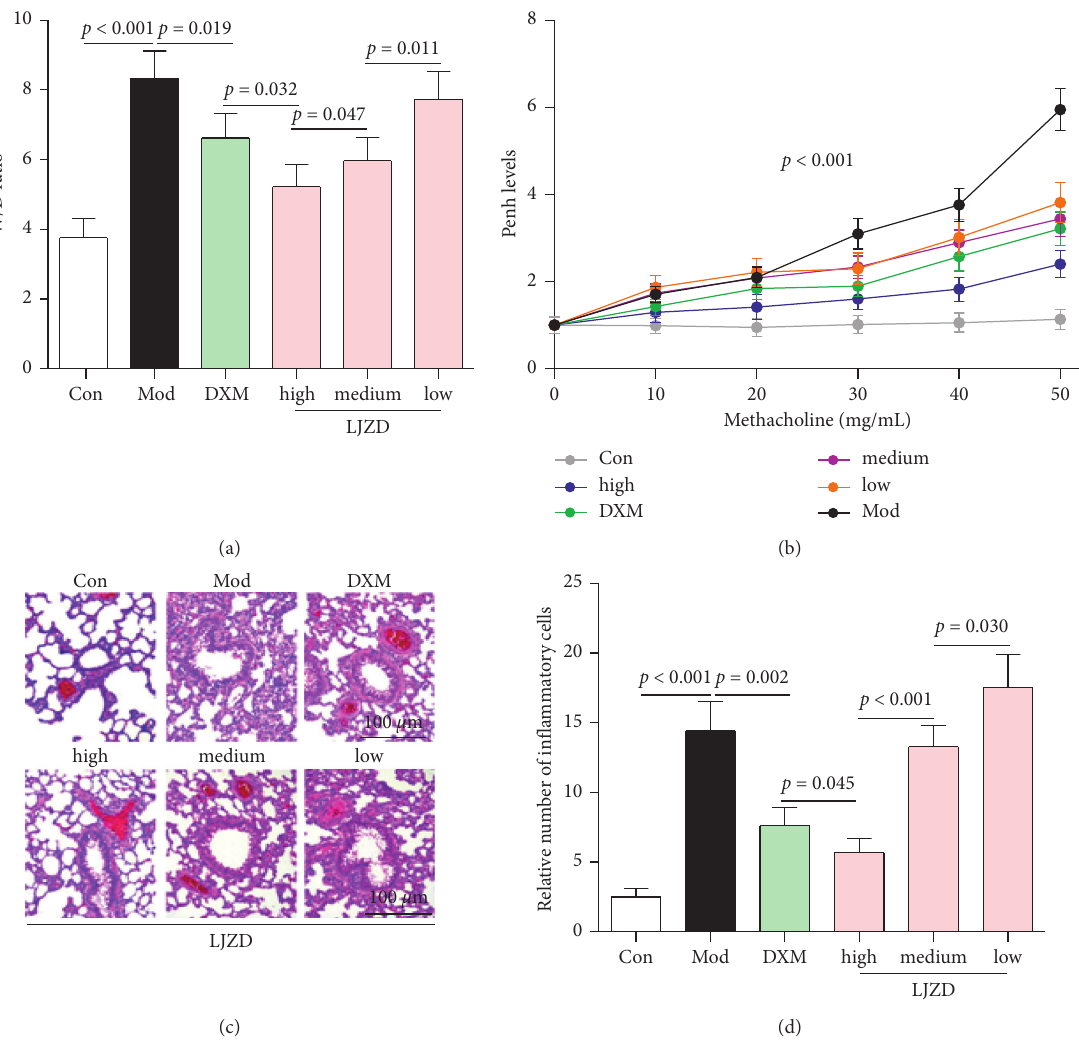
Figure 1: LJZD improved OVA-induced asthma in Balb/C mice. (a) The W / D ratio of the right lungs in the Con, Mod, DXM, and high-, medium-, and low-dosage LJZD groups. (b) The Penh levels represented air hyperresponsiveness of mice in all the groups. (c) Representative H & E staining images of the right lungs in all the groups. (d) The relative number of inflammatory cells in H & E staining of all the groups. Data were expressed as the mean ± SD ( n � 3). LJZD: LiuJunZi decoction, OVA: ovalbumin, W / D : wet weight/dry weight, Con: control, Mod: model, DXM: dexamethasone, H & E: hematoxylin and eosin, and SD: standard